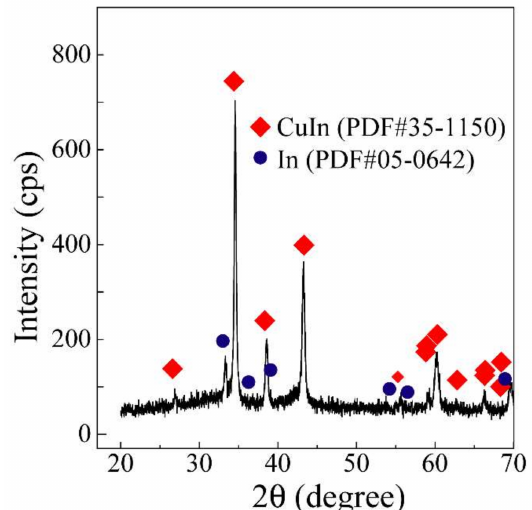
Figure 3. XRD profile of the material synthesized from the 0.01 M CuCl 2 -0.01 M InCl 3 -0.50 M ASP aqueous solution (pH 9, 30 ◦ C, reaction time was 1